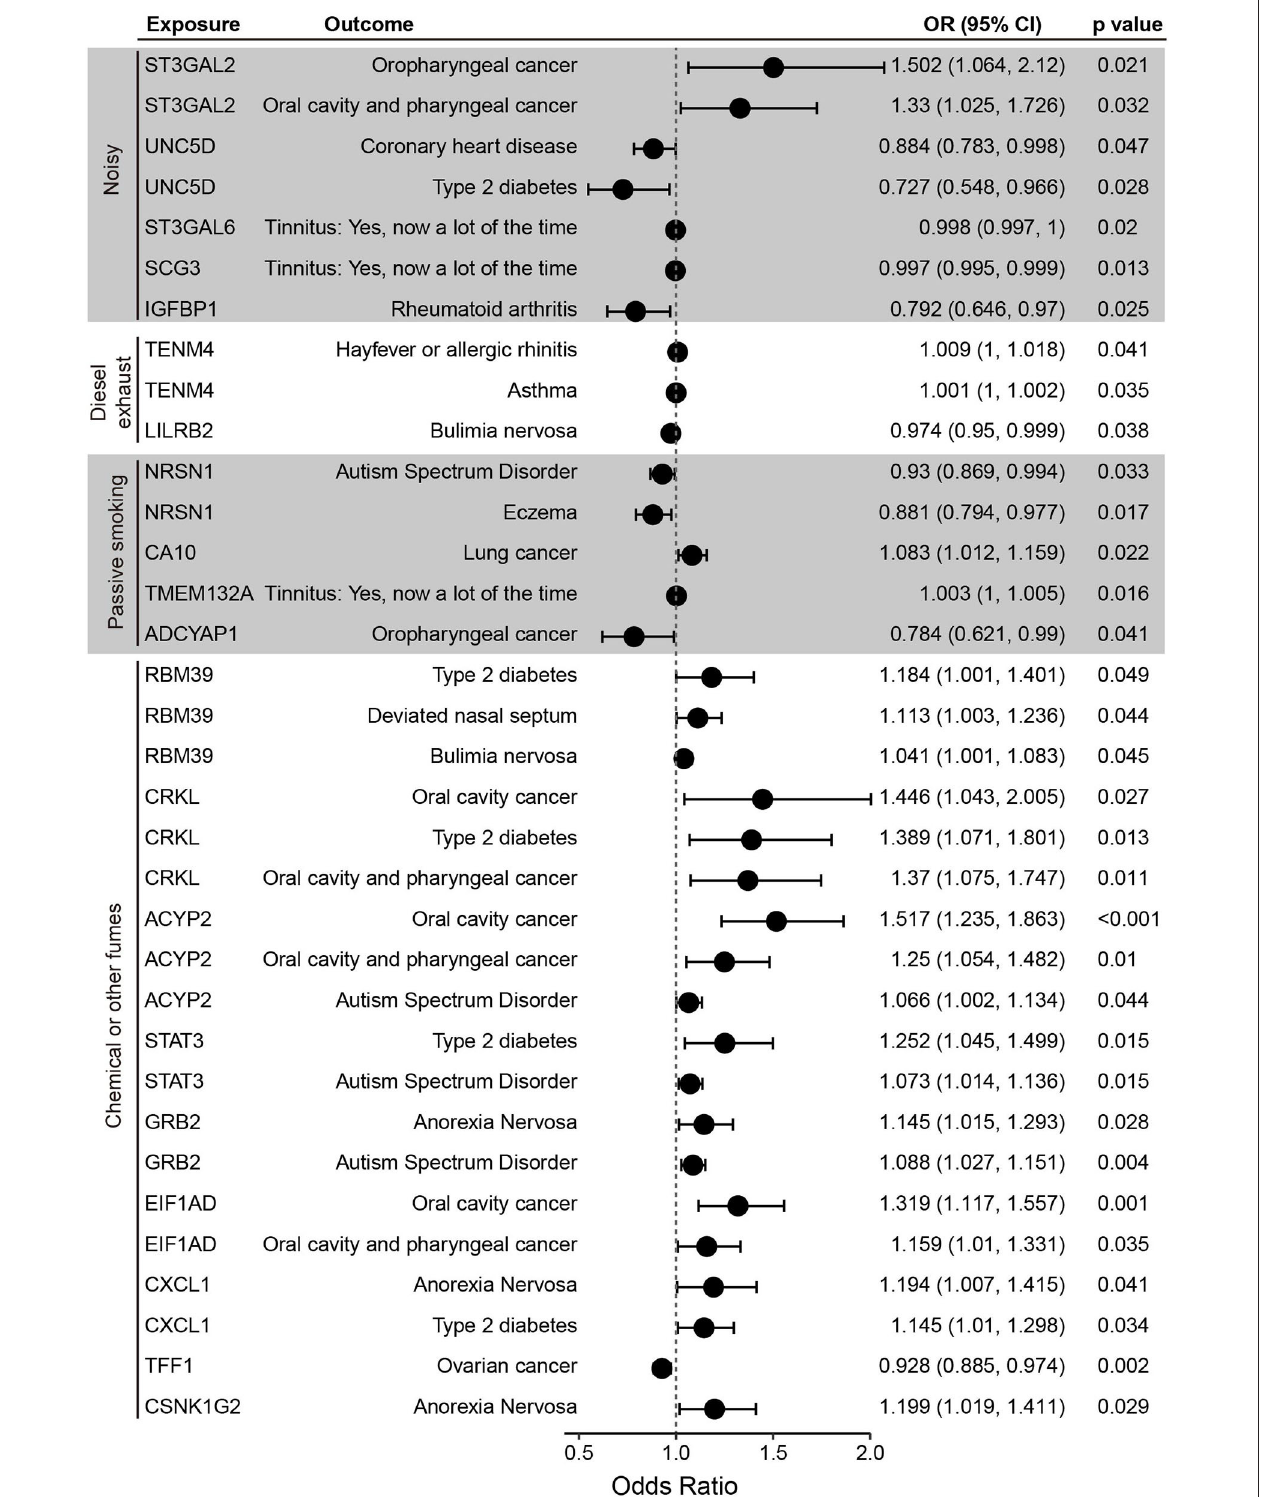
FIGURE 3 | Forest plot of Mendelian randomization (MR) results of the relationships between plasma proteins and selected diseases. Shown are the odds ratios (ORs), 95% confidence intervals (CIs) and p -values of MR analysis performed using the inverse variance weighted (IVW) method.